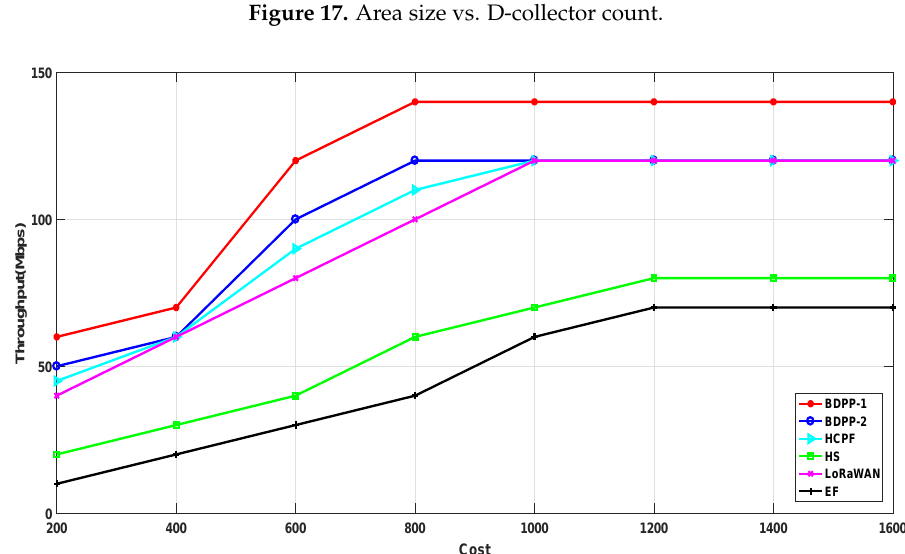
Figure 17. Area size vs. D-collector count.